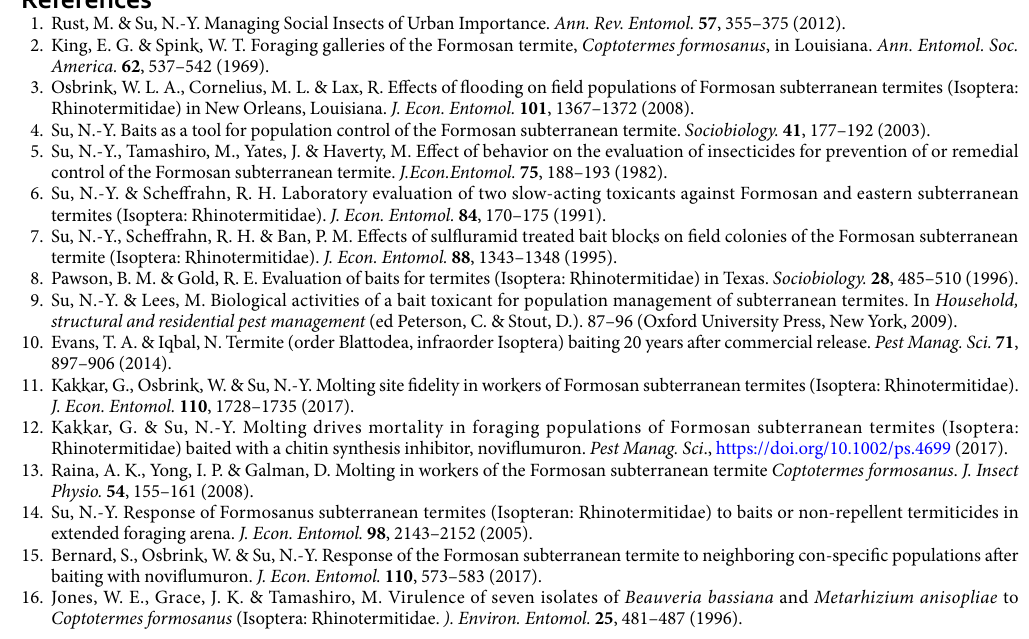
treatment chamber was added to the Tygon tubes connecting the corner most planar arena to the adjacent planar arena. For each treatment (control and noviflumuron), three juveniles colonies were used as the replicates, total- ing six colonies for the study. For control, colonies (A, B, and C) were provisioned with cellulose pads dyed with Nile Blue A (0.05% wt/wt), and for treatment, colonies (D, E, and F) were treated with cellulose pellets containing 0.5% noviflumuron and dyed with Nile Blue A (0.05% wt: wt). The dye was added to confirm termite feeding from the treatment chamber. The planar arena closest to the treatment chamber was referred to as 0 m arena, and others as 5 m, 10 m, 15 m, 20 m, 25 m in reference to the treatment chamber, hence the central nest was initially located at 25 m from the treatment chamber. Visual count of workers (blue and white) in the process of molting and the ones which have recently molted based on their mandible color due to varying levels of sclerotization 25 were made in both control and treatment units. Also, visual counts of any freshly dead workers, moribund (laid on side or back), and work- ers in molt-inhibitory postures formed under the effect of noviflumuron 26 were recorded. Counts were recorded from each planar arena across 25 m long foraging setup starting from the day treatment chamber (cellulose pads/ noviflumuron + 0.05% Nile Blue A) was added to the unit at five days interval until the colony collapsed (0 d, 5 d, 10 d, and so on). Because termites may feed on or bury corpses, counts included only freshly dead workers in each planar arena observed at the time of data collection. Data analyses. Comparisons for the molting and mortality count ( = variable) between control and novi- flumuron treated colonies on all sampling dates for each colony were analyzed independently using a repeated measure one-way ANOVA in a generalized linear mixed model with the SAS 27 procedure GLIMMIX. The model was used to determine the effect of treatments, sampling period (time), and their interaction on molting and mortality amongst workers, separately. Because the response variable was count data with no upper bound, in the model statement distribution was specified as Poisson. Data were transformed using log 10 (x + 1) to homogenized variance before analysis. Each termite colony represented a replicate for a total of three replicates. Data presented in table and figures represents un-transformed means of molting and mortality.